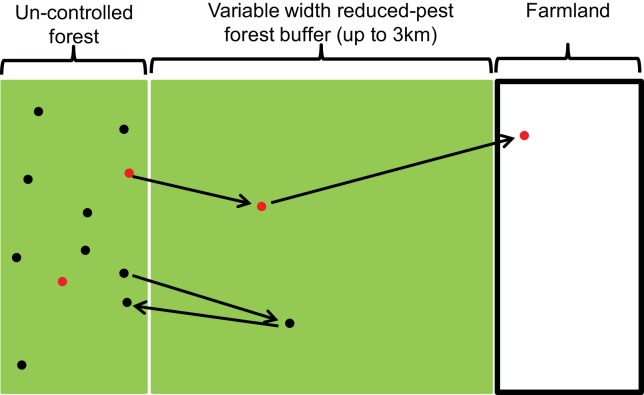
Schematic illustration of simulations used to determine the probability of an M. bovis-infected possum arriving in farmland by traversing a forested buffer.Initially, possums were placed randomly in an un-controlled forest block (black dots are locations of uninfected possums; red are infected). Arrows represent hypothetical examples of subsequent dispersal and exploratory movements.